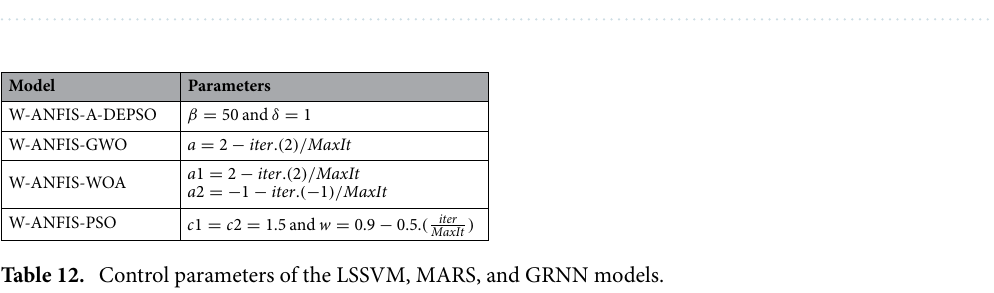
Figure 16. Relative deviation to forecast the EC using ML models coupled with Bior6.8 (upper) and Dmey (lower) mother wavelets.